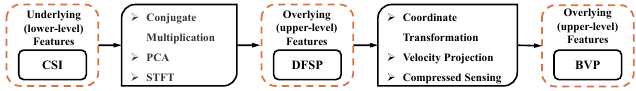
Figure 2. Inference from CSI to DFSP and